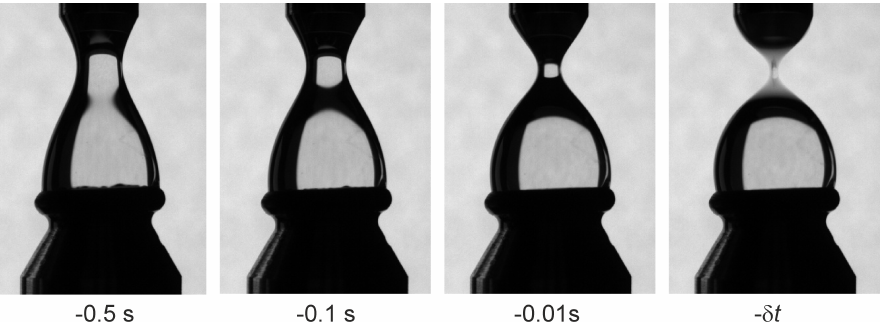
Figure 4. The isotropic bridge of ST02890 (TX52/4) at different times before pinch-off ( α = 2.26 ± 0.03), where δ t is less than 10 ms. Because of a technical issue, the bridge was asymmetric and had a base diameter that was 1.5 times larger than the top diameter. The image sizes are 8 mm × 11 mm.